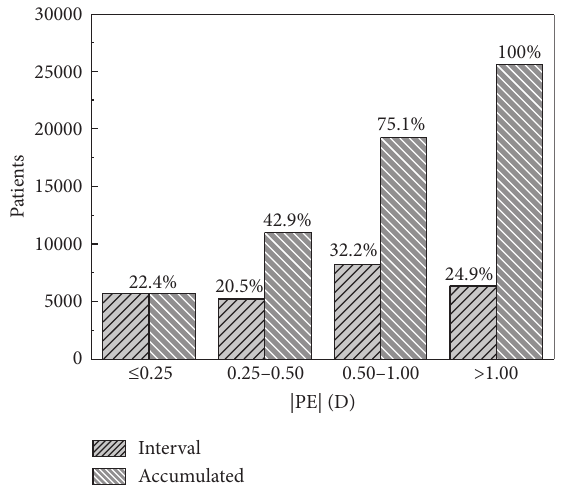
Figure 10: Distribution of the absolute value of the PE in intervals, and its cumulative values. Table 3: Gender segmentation of the